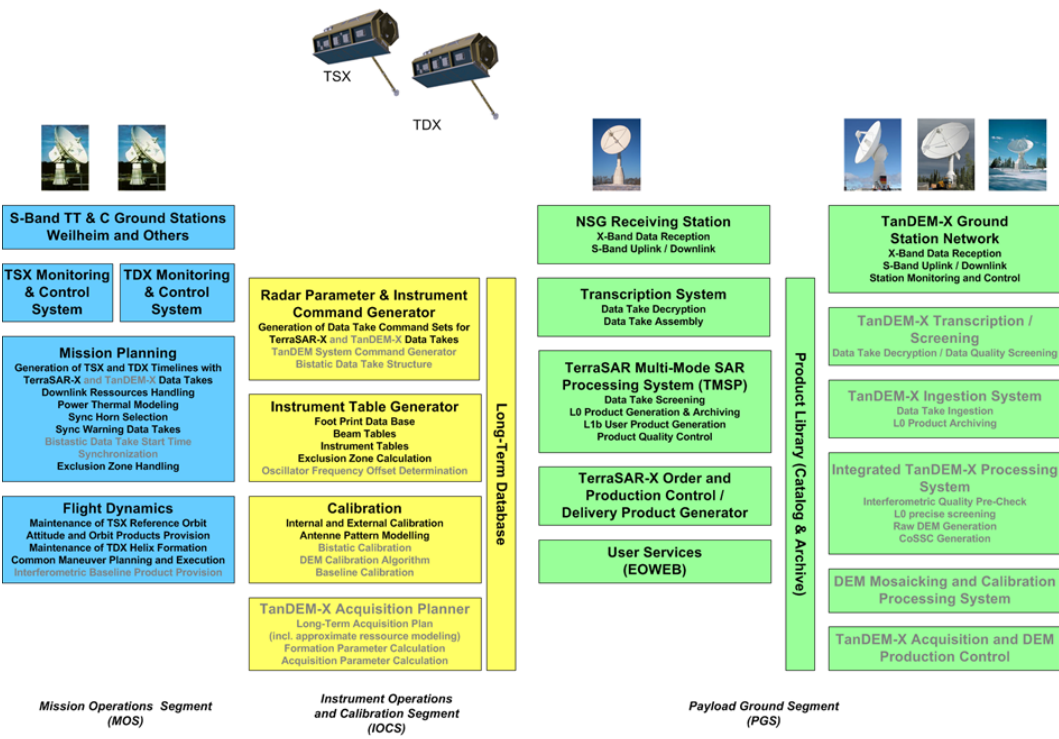
Figure 1. Sketch of main subsystems and components of the common TerraSAR-X/TanDEM-X ground segment. TanDEM-X mission specific parts are in grey.